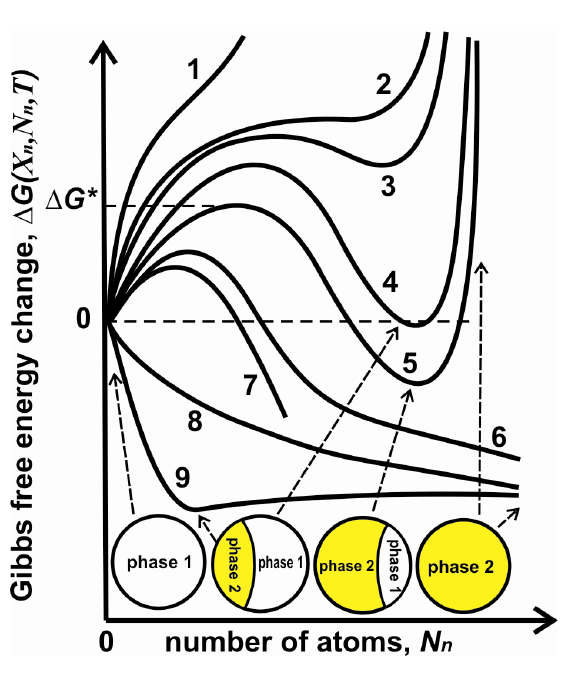
Figure 3: The Gibbs free energy changes Δ G ( X n , N n , T ) as functions of the number of atoms N n . The case 7 represents the classical Gibbs thermodynamics and curves 1–6, 8 and 9 – the modification of the classical thermodynamics for transforming multicomponent isolated nanosystems, cases 4, 5 and 9 give stable two-phase states; cases 4–6 and cases 8 and 9 correspond to transition with and without energy barrier, respectively. The right ends of Δ G ( X n , N n , T ) curves correspond to the totally transformed nanoparticle with new nanophase 2 (as shown in Figure 2c). Cases 6, 8 and 9 show that the nanophase 2 is energetically advantageous as compared with nanophase